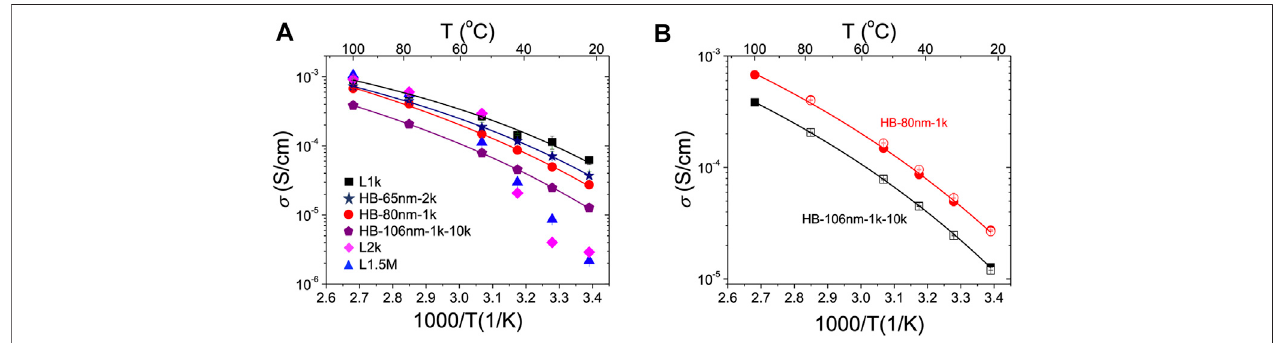
FIGURE 4 | Temperature-dependent ionic conductivity showing the effect of HB PEO molecular architecture and thermal history. Measured conductivity ( σ ) vs. 1,000/T (K − 1 ) of (A) HB and linear PEO electrolytes and (B) HB-80nm-1k (circles) and HB-106nm-1k-10k (squares) upon heating ( fi lled symbols) and cooling (open symbols). The solid lines in (A) and (B) are fi ts using the Vogel-Tamman-Fulcher Eq. 2 . Samples are equilibrated at each temperature for 10 min before data